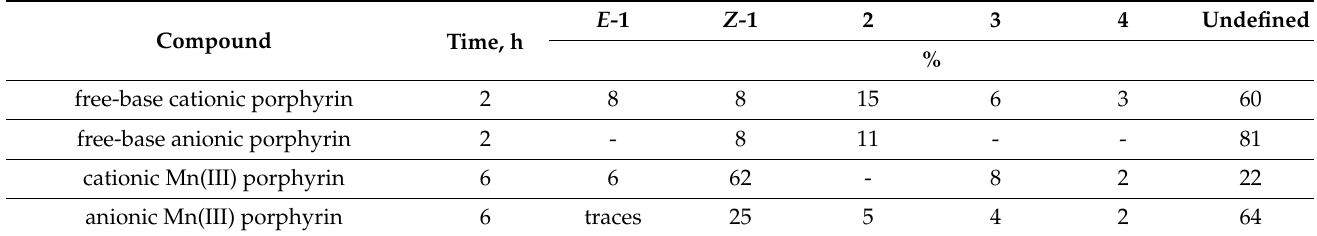
Table 2. Photoproducts with isolated yields (%) obtained using Mn(III) and free-base cationic/anionic porphyrins and the remained E - 1 for synthesis performed in a batch